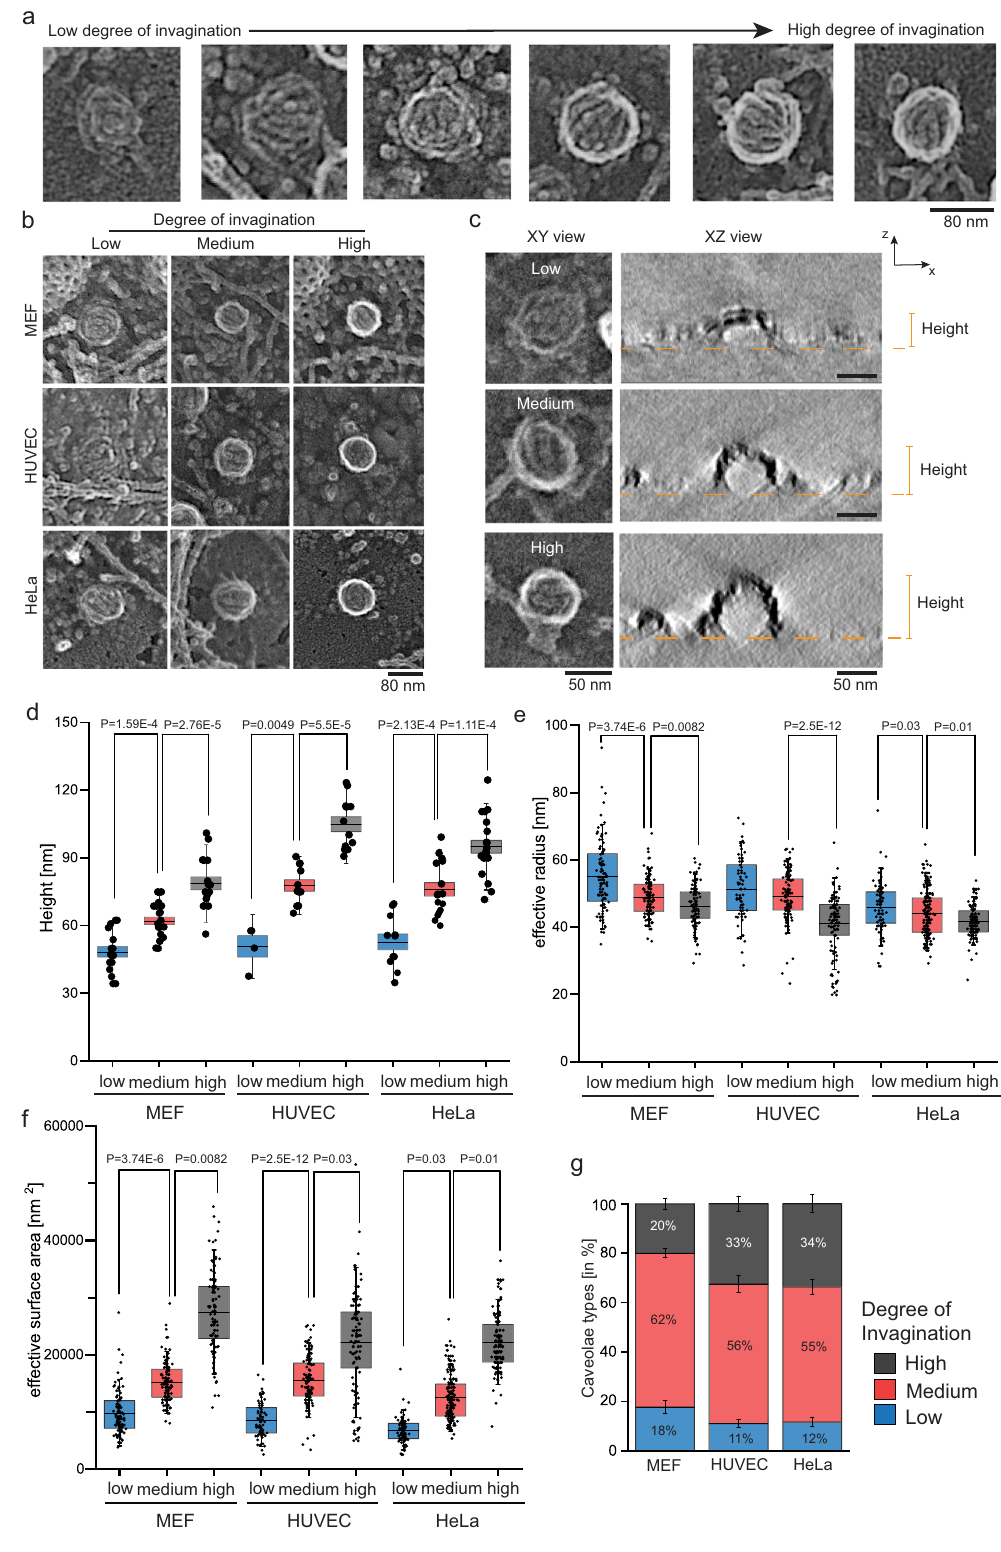
low, medium, or highly curved caveolae groups (Suppl. Fig. 3a). When line scans of the gray value pro fi le were normalized and plotted from the center of the individual organelles toward their edges, the averages of different caveolae types could be dis- tinguished (Suppl. Fig. 3b). Low curved caveolae exhibited mini- mal intensity difference on average between the center, edge,